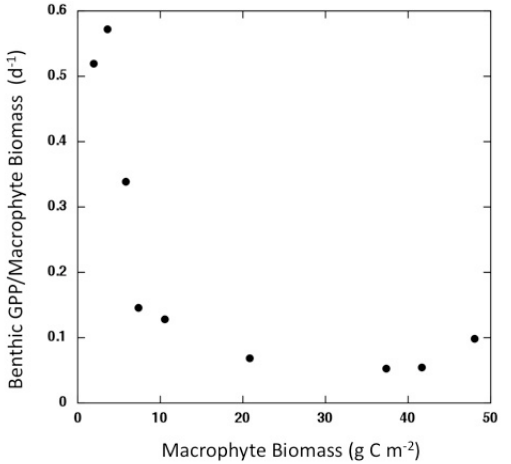
Fig. 4. The relationship between the ratio of daily benthic gross production to macrophyte biomass and macrophyte biomass in the nine lagoons.